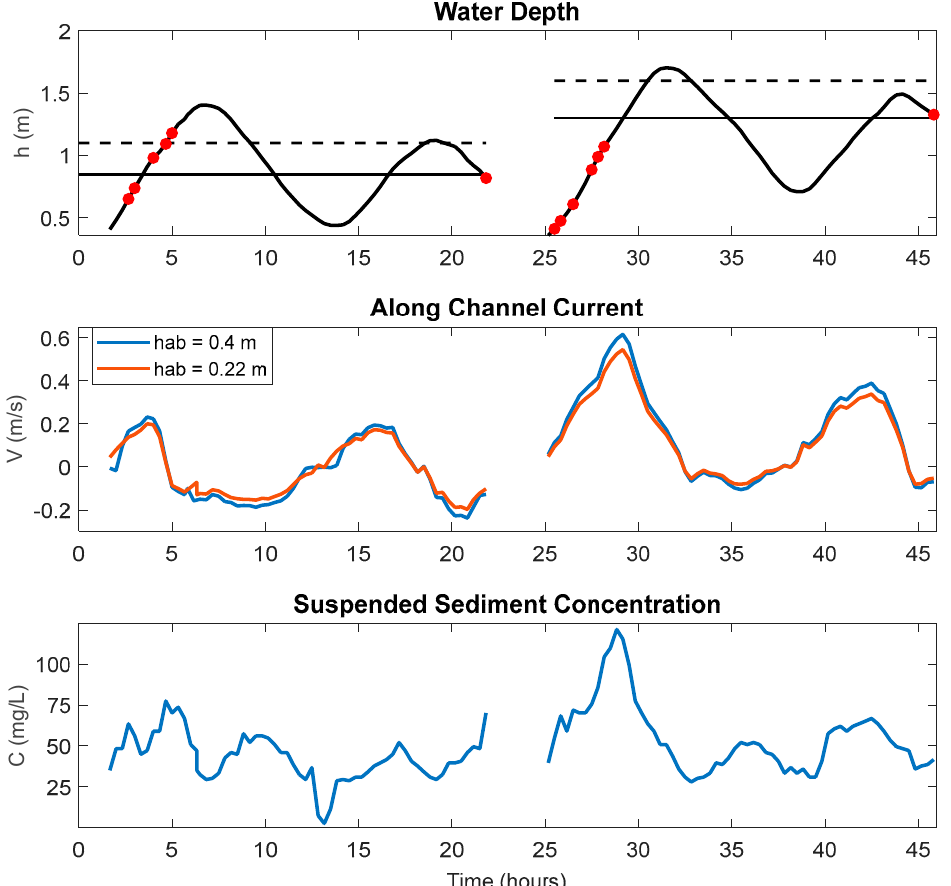
Figure 4. Time series of the burst averaged water depth, along the channel current, and suspended sediment concentration. Station 1 sampling occurred during the first 24 h of the field e ff ort and Station 2 sampling occurred during the remainder of the field e ff ort. The solid horizontal lines on the water depth plot denote the scarp elevation and the dashed lines denote the marsh platform. The circles denote vessel passage events.